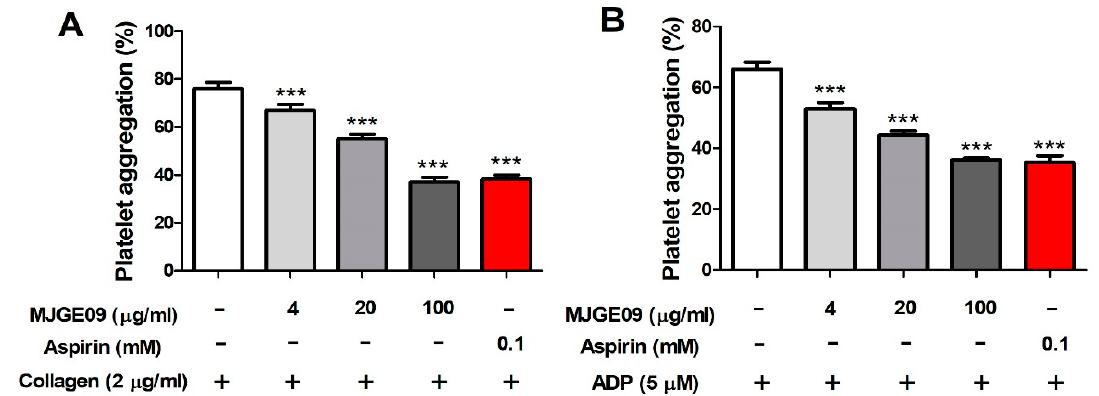
Figure 3. Inhibitory effects of the MJGE09 extract on in vitro platelet aggregation. Platelets were pre-incubated for 5 min with various concentrations of MJGE09 (4, 20, and 100 µ g/mL) before being aggregated with 2 µ g/mL collagen ( A ) or 5 µ M ADP ( B ). Data represent the mean ± S.E.M ( n = 6). Statistical significance was set at *** p < 0.001 when compared with the control group.